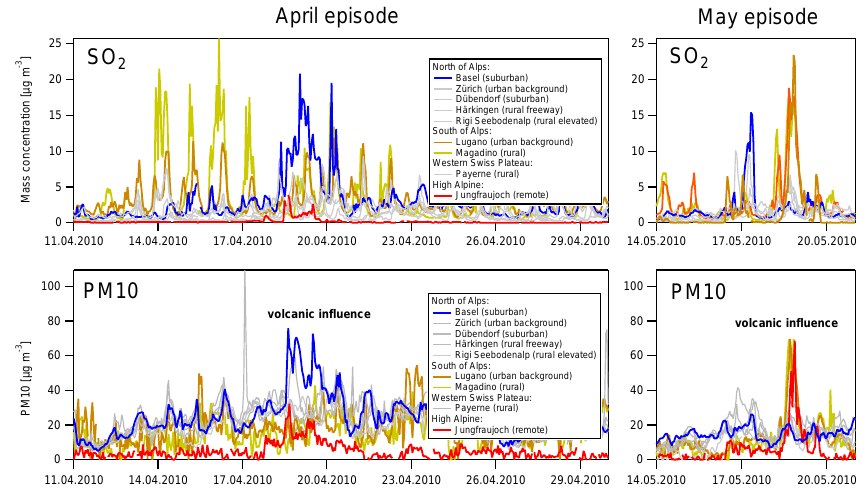
Fig. 13. April and May 2010: identification of stations with increased PM 10 and SO 2 concentrations within the Swiss Air Pollution Moni- toring Network, indicating the presence of volcanic aerosol.